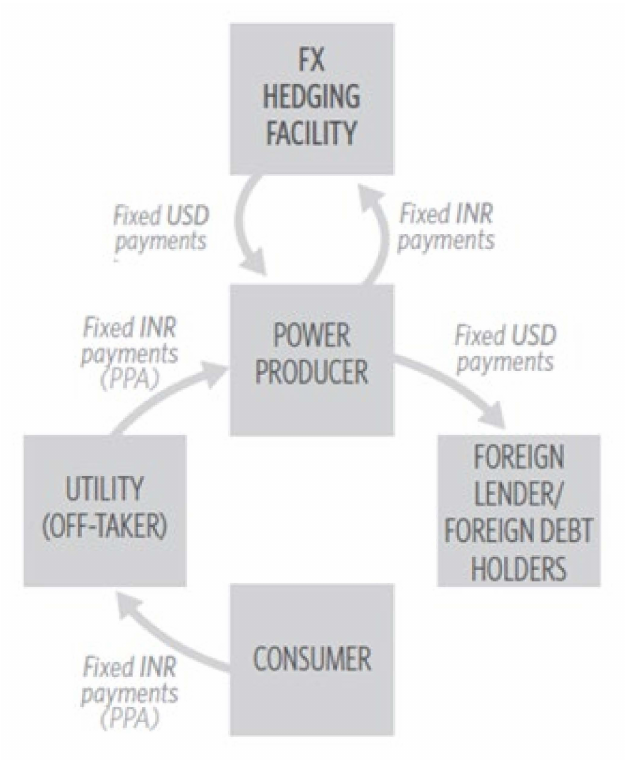
Figure 3. Cash flows in a local currency PPA